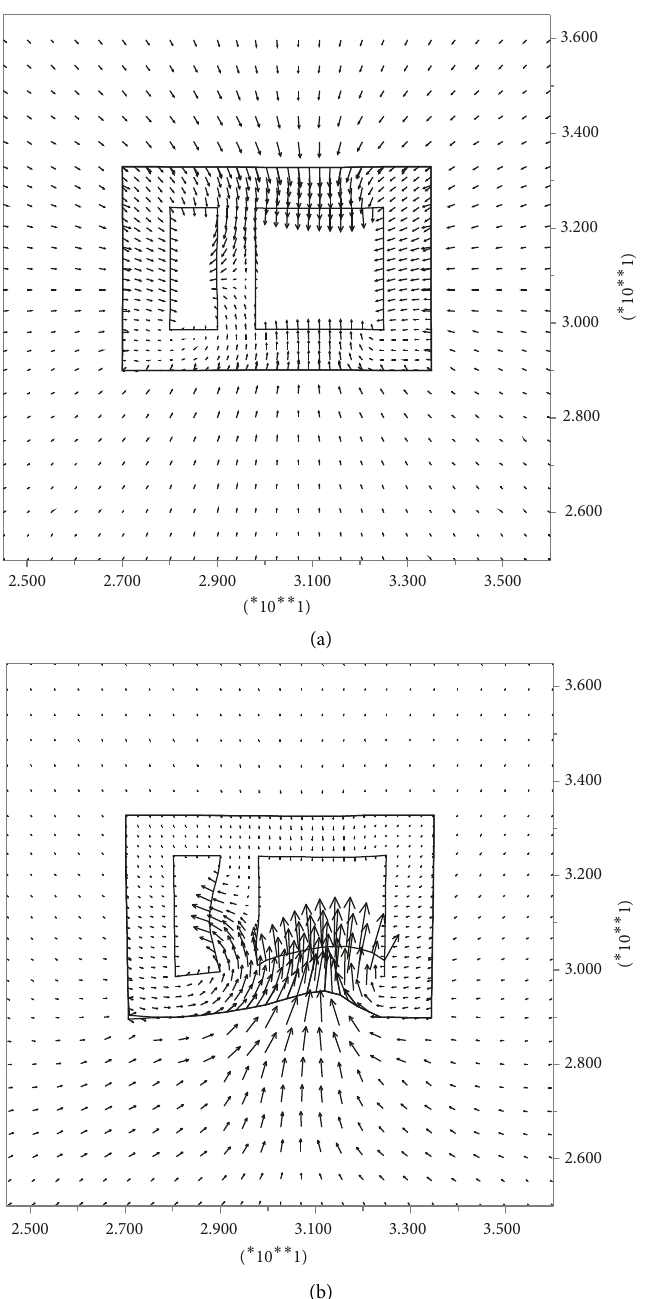
Figure 10: Comparison of displacement distribution under conditions (a) without water and (b) with